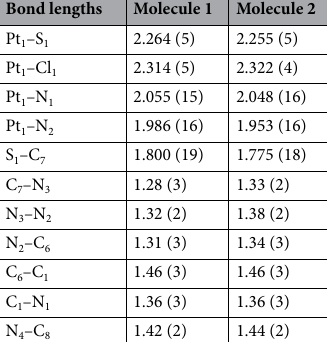
Bond lengths Molecule 1 Molecule 2